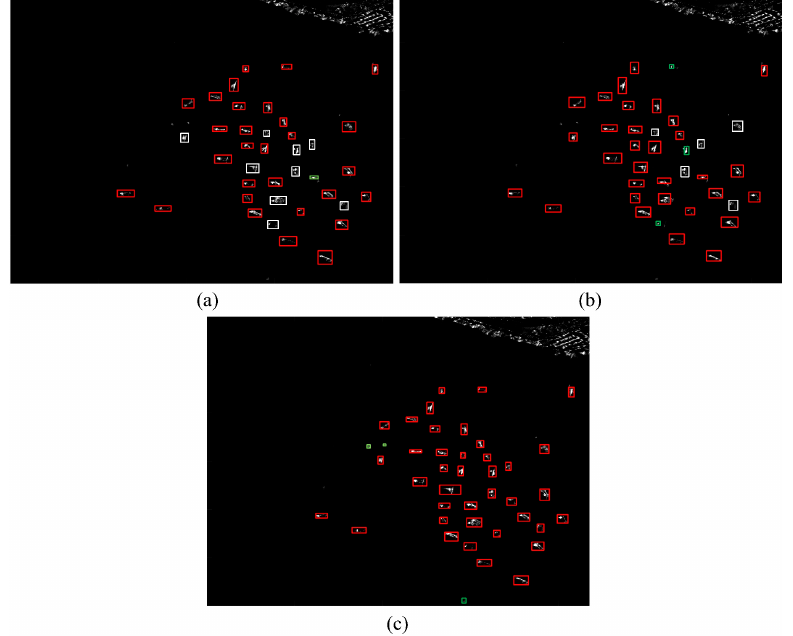
Figure 11. The detection results. ( a ) Yolo_v3 result. ( b ) Densely-faster-RCNN result. ( c ) Proposed method. The red, white, and green rectangles represent the correct detection ships, the missing ships, and the false alarms, respectively.